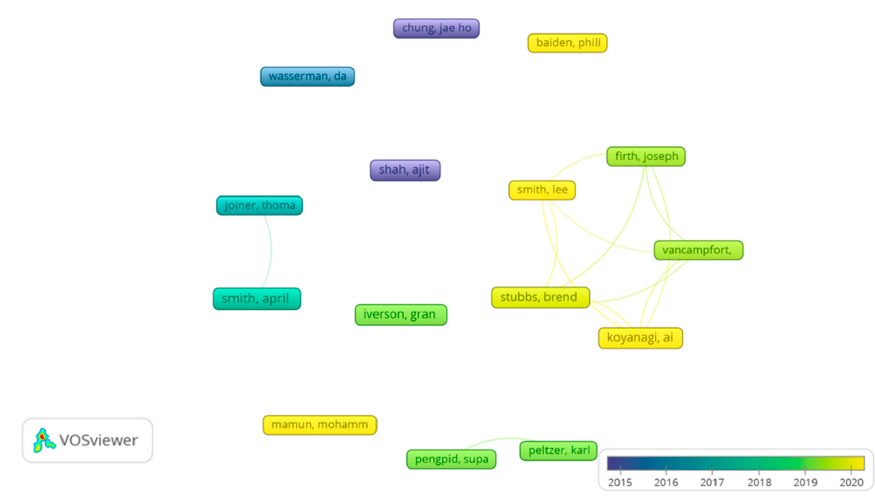
Figure 3. Interrelations between the most prominent co-authors.